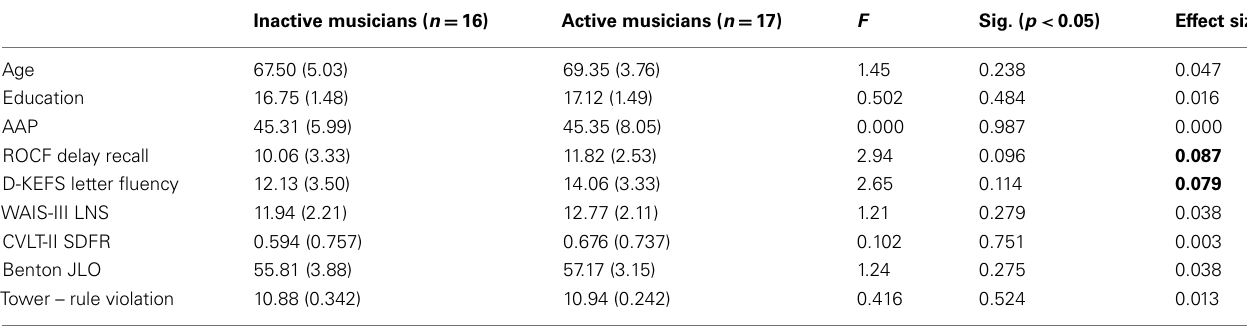
Table 2 | Means (SDs) scaled scores and significance for inactive and active musicians.